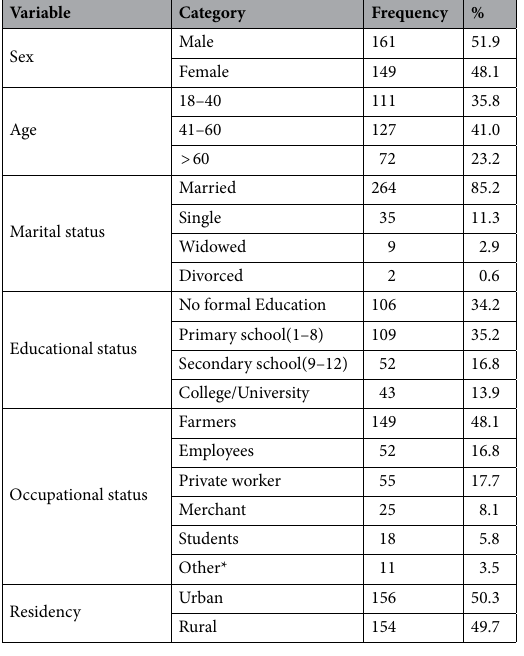
Table 1. Socio-demographic characteristics of the study participants, 2021. *Students, and daily